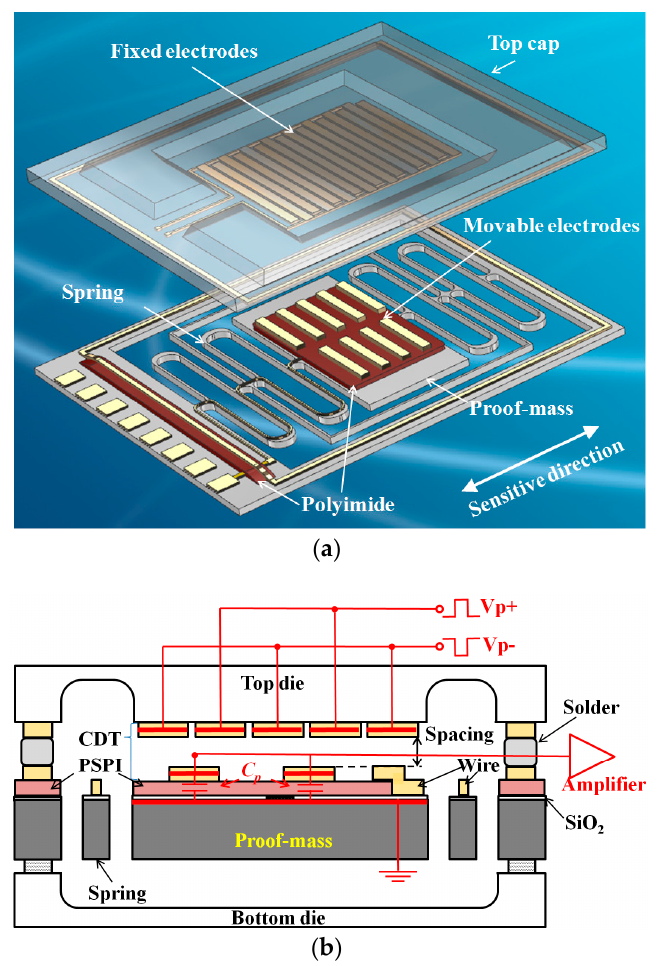
Figure 1. Schematic of the micro accelerometer using an encoder-like area-changed transducer. ( a ) Structure of the capacitive accelerometer. The spring-mass system is also used as a micro position actuator for the calibration of the capacitive transducer; ( b ) Section view of the capacitive accelerometer, the electrodes on the top die and the proof-mass die form the capacitive displacement transducer (CDT); a photosensitive polyimide (PSPI) is inserted for reducing the parasitic capacitance.